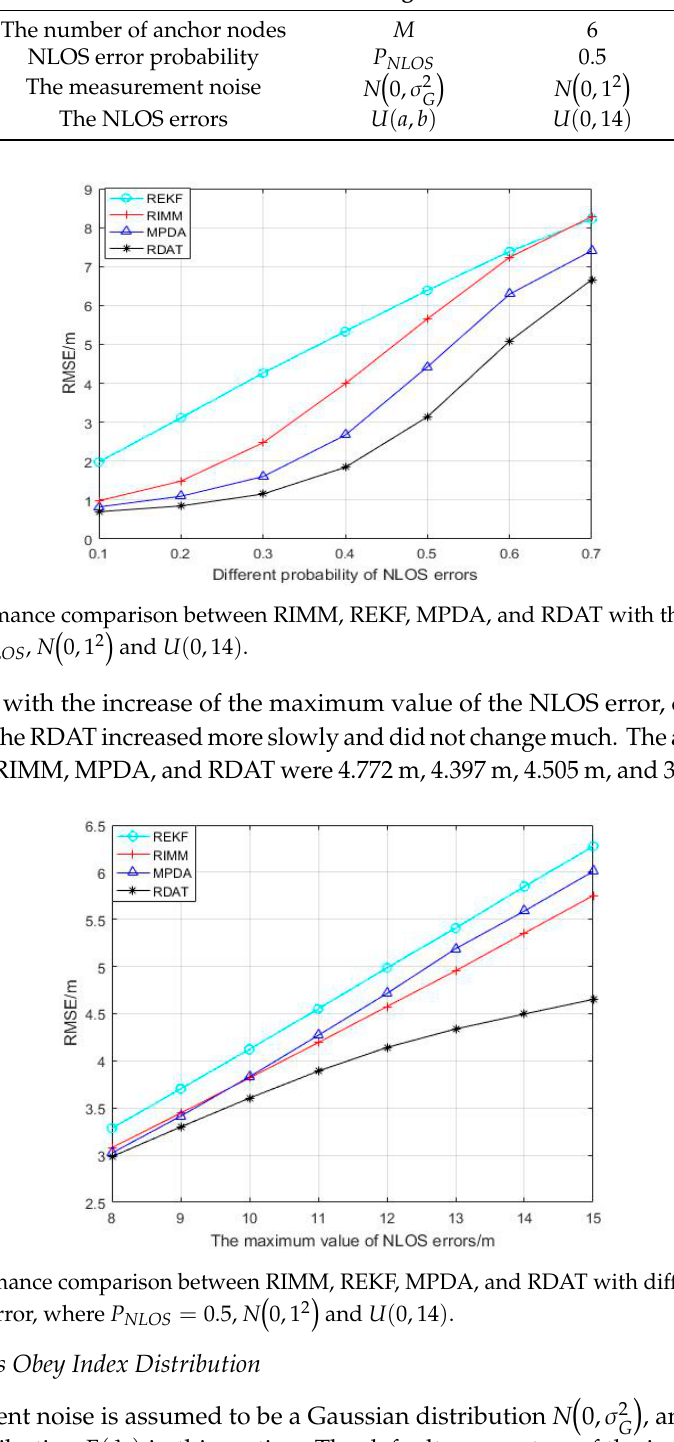
Table 3. Index distribution parameter.